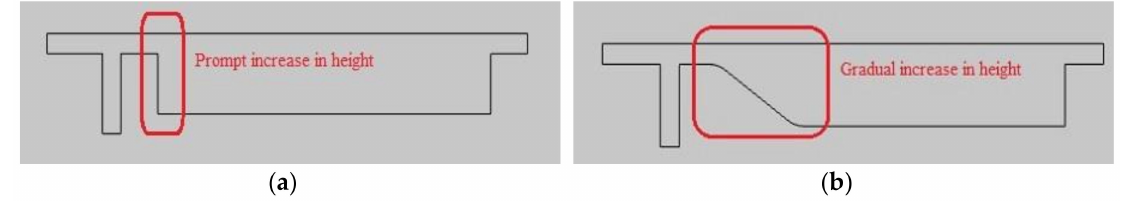
Figure 7. Representation of possible ways for increase in cross section: ( a ) prompt increase; and ( b ) gradual increase.